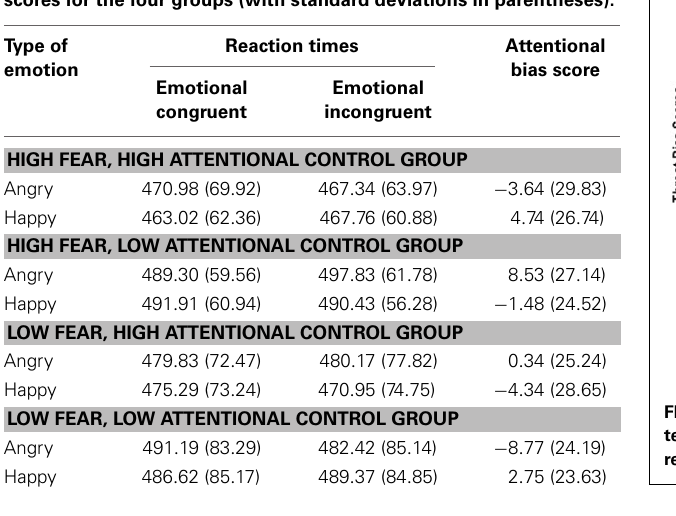
Table 2 | Mean threat reaction times for each condition and mean bias scores for the four groups (with standard deviations in parentheses).